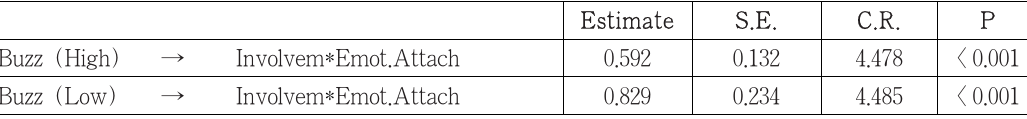
<Table 5> Testing Moderating Effect for